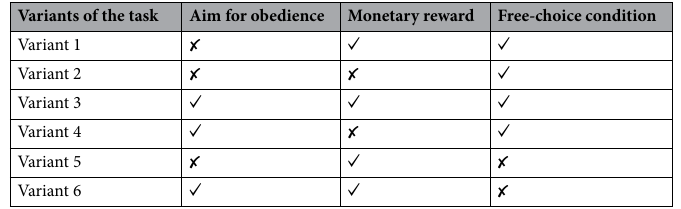
Table 1. Schematic representation of each variant of the experimental